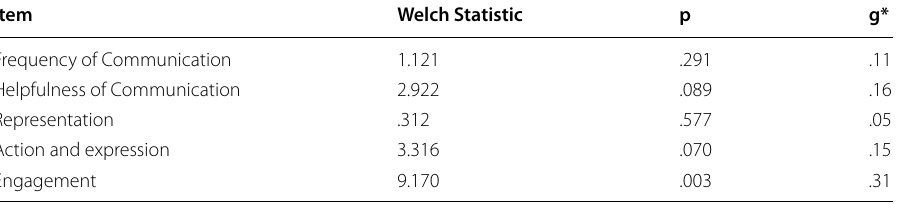
Table 4 Differences in quality of instruction gain scores between students eligible for disability services and other students